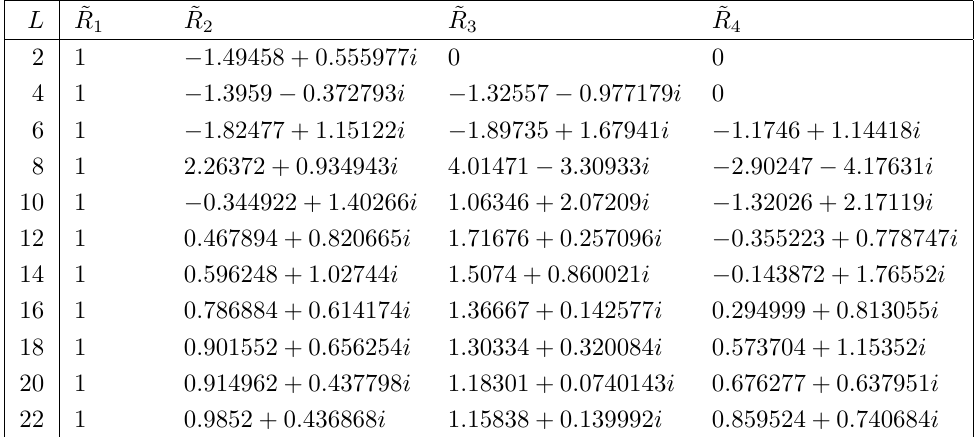
Table 6 . ˜ R m (A.4) of Φ D at the truncation level L for m = 1 , 2 , 3 , 4 . a = − 1 / 2